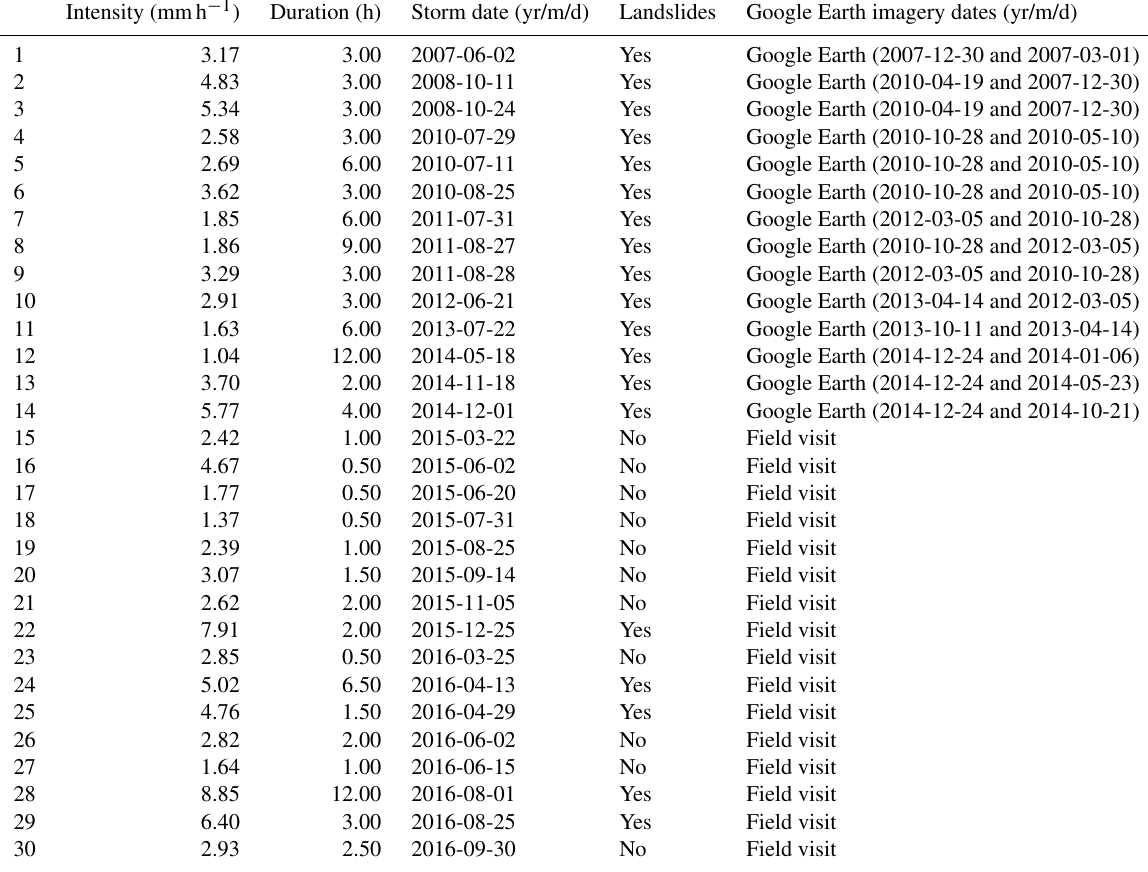
Table 1. Intensity and duration of the precipitation events used for the construction of the Faifa ID curve. Landslide-producing storms were verified through field observations and by examining spectral and morphologic variations in pairs of Google Earth archival images bracketing significant storm events.